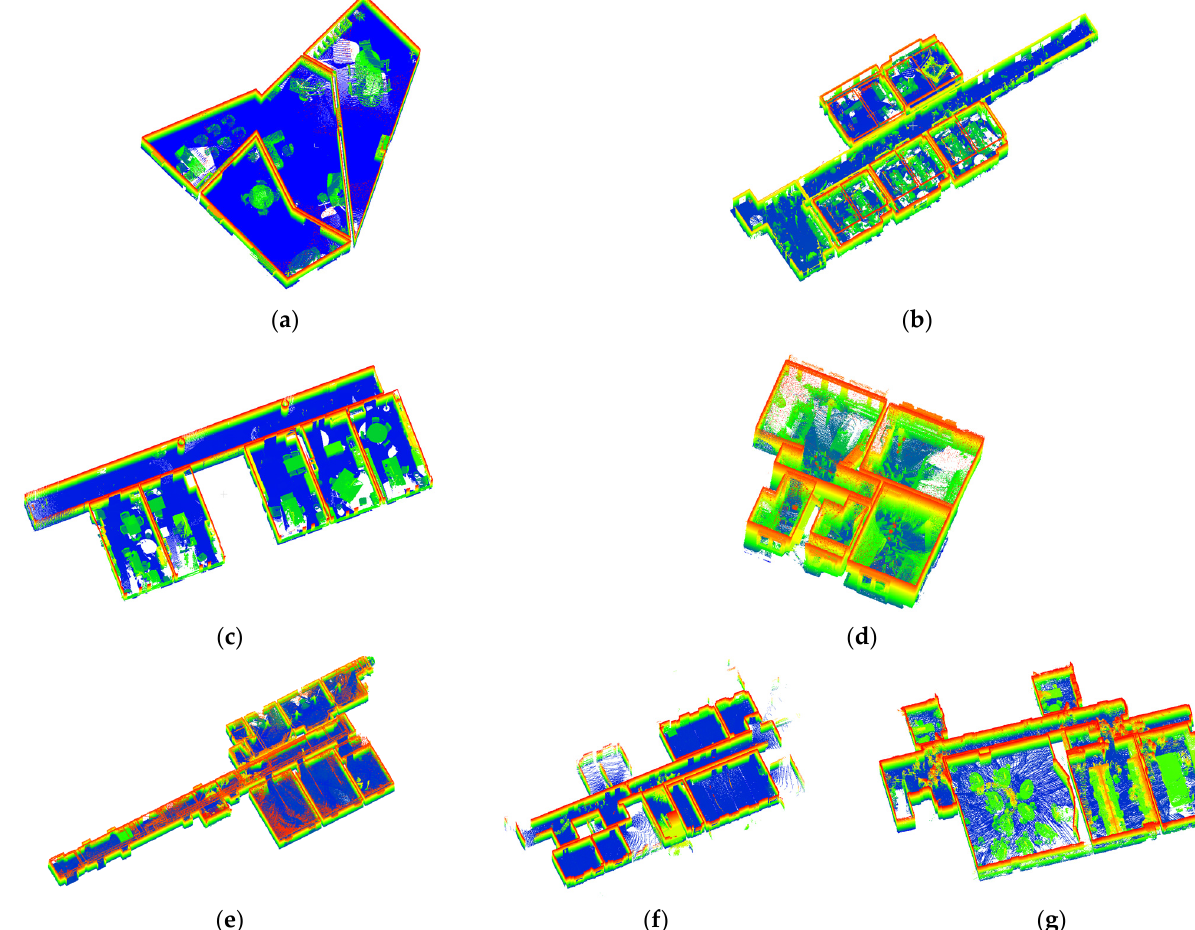
Figure 12. Datasets: ( a ) Synth; ( b ) Office1; ( c ) Office2; ( d ) Room; ( e ) TUB1; ( f ) TUB2; ( g ) UOM.